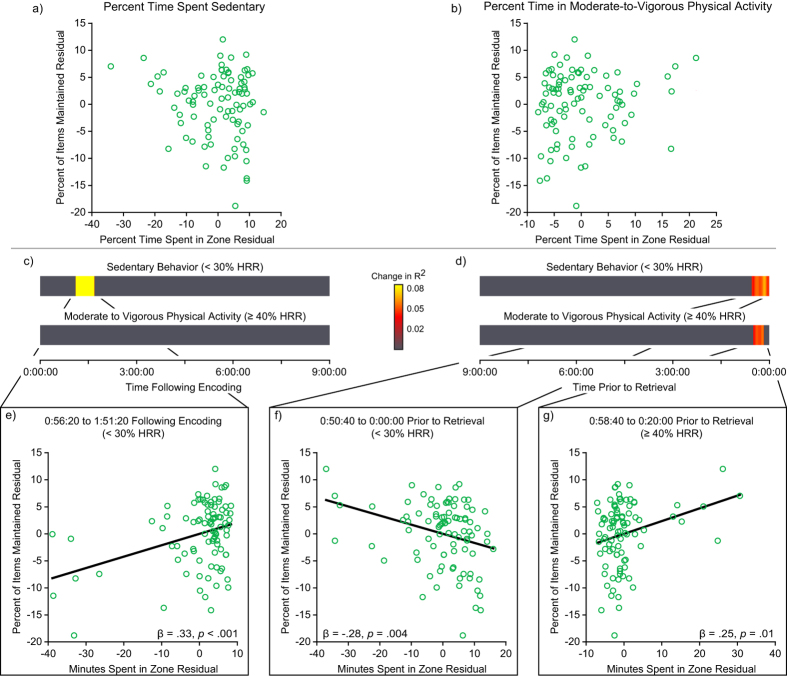
The plots along the top of the figure present the relationship between the proportion of items maintained between session 1 and session 2 and the percent time spent sedentary (a) and the percent time spent in moderate-to-vigorous physical activity (b) throughout the entire day, controlling for the influence of Age, Sex, and Aerobic Fitness. The middle plots present the change in R2 from the hierarchical linear regression for the 20 minute period surrounding each point across a 9 hour period time-locked to the first session (c) and a 9 hour period time-locked to the second session (d) controlling for the influence of Age, Sex, and Aerobic Fitness. The bottom plots provide scatterplots of the relationship between residuals for the proportion of items maintained between session 1 and session 2 and the number of minutes spent sedentary (e,f), and in moderate-to-vigorous physical activity (g) during the critical periods identified, controlling for the influence of Age, Sex, and Aerobic Fitness.